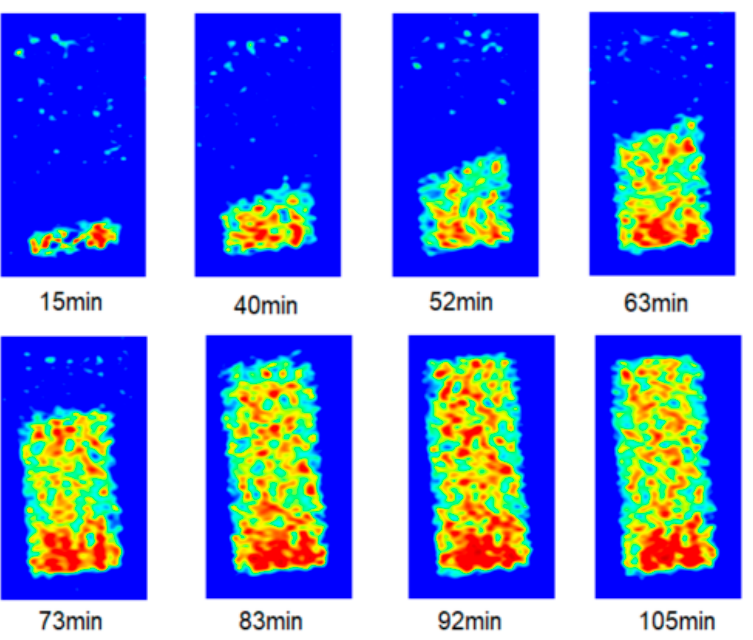
Figure 5. NMR imaging results of the fracturing fluid imbibition process in core 96 at various moments.